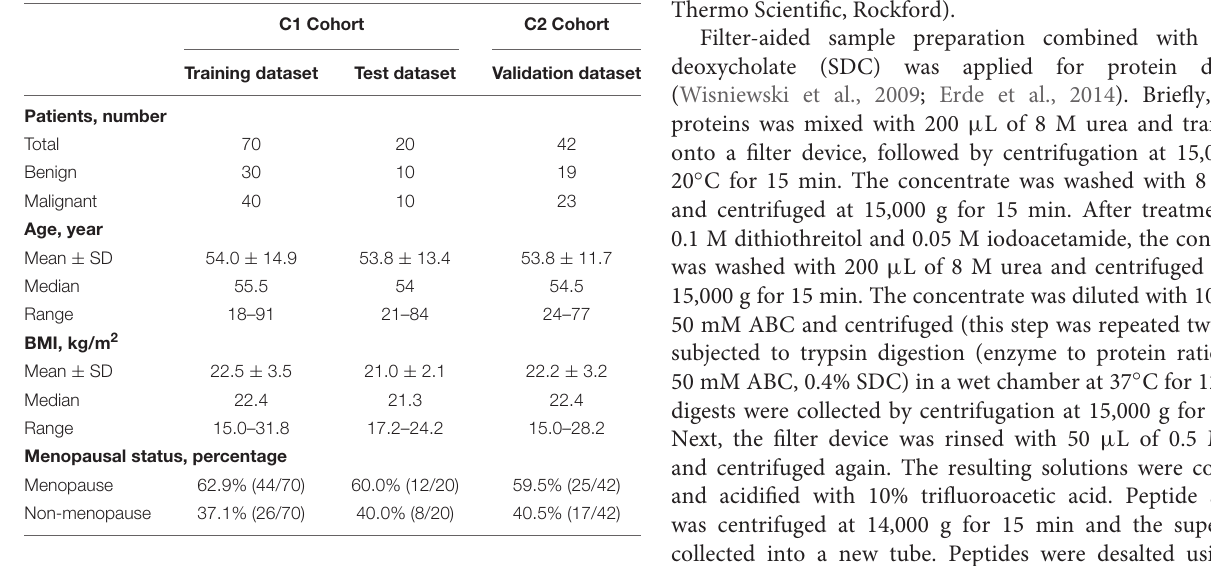
Frontiers in Cell and Developmental Biology |